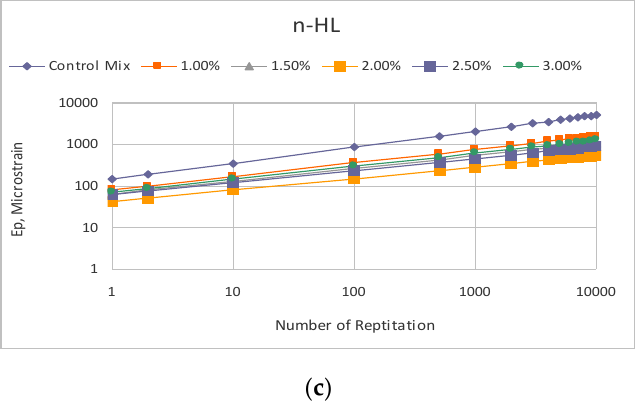
Figure 16. Comparison of the permanent deformation. ( a ) r-Hl, ( b ) sn-HL and ( c ) n-HL.